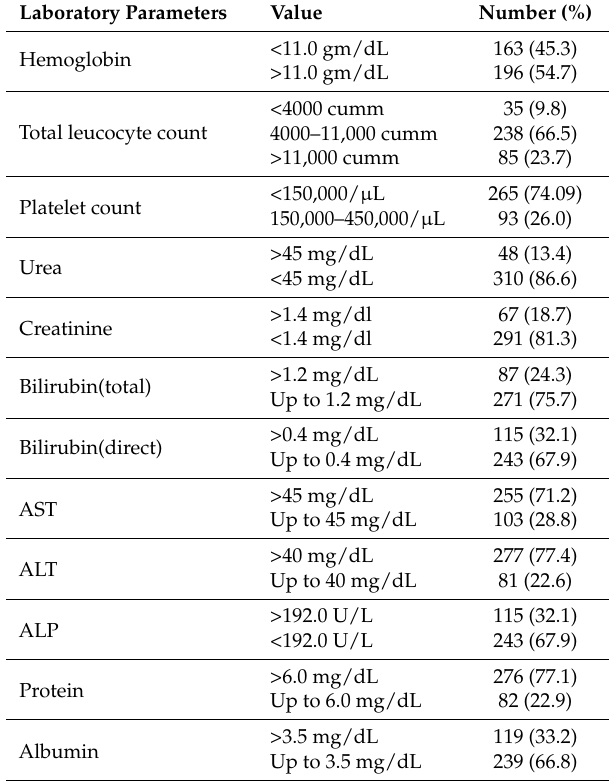
Table 3. Laboratory parameters of scrub typhus cases ( n =